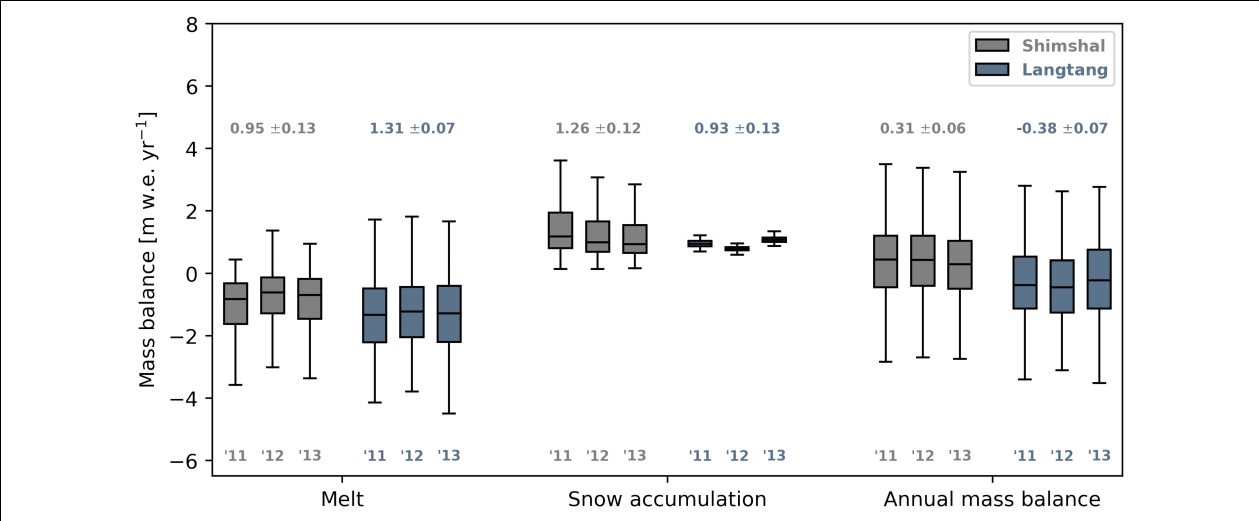
FIGURE 10 | Box plots of the effect of the melt and snow accumulation on the glacier surface mass balance, and the annual mass balance for each simulated year shown for Shimshal (gray) and Langtang (blue). The 3-yearly mean and standard deviation is shown above the boxplots for each category and